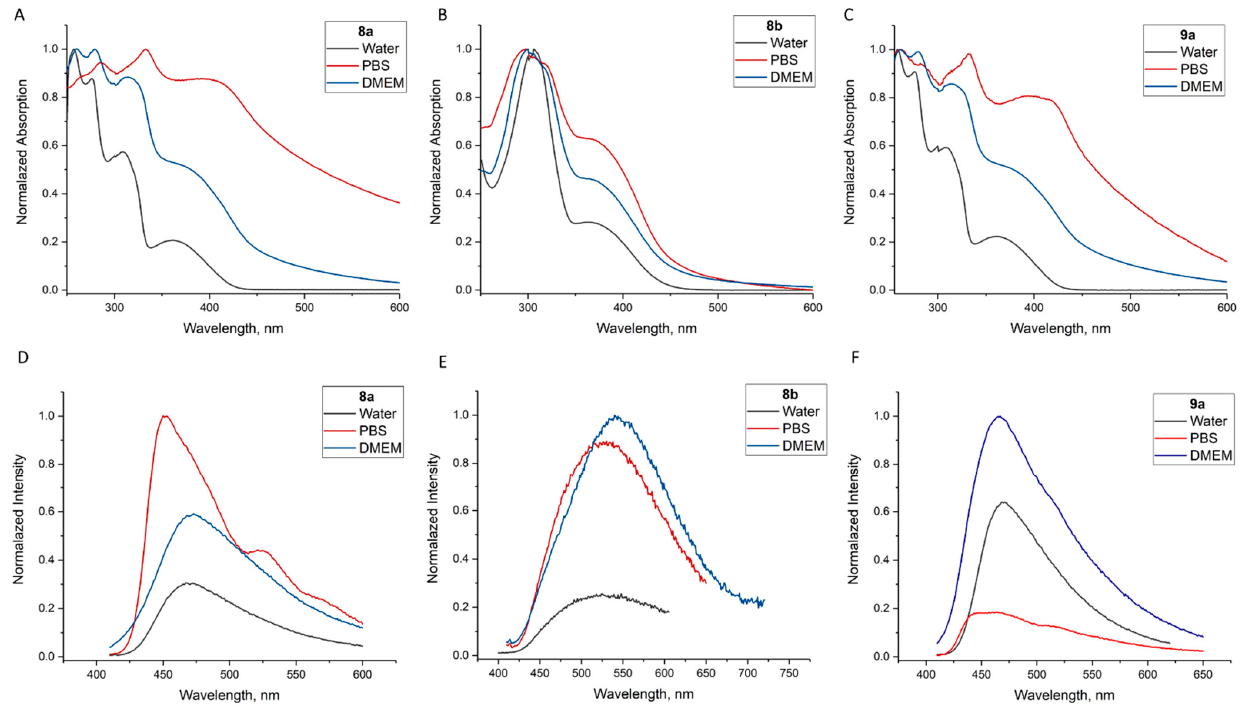
Figure 6. UV–Vis ( A – C ) and fluorescence ( D – F ) spectra of 8a , b, and 9a in water/DMSO (0.5%, v / v ), PBS/DMSO (2%, v / v ), and DMEM/DMSO (2%, v / v ). The fluorescence intensity of the solutions of the most compounds in PBS buffer and DMEM increased in comparison with the fluorescence intensity for the corresponding so- lutions in water (Figure 6).